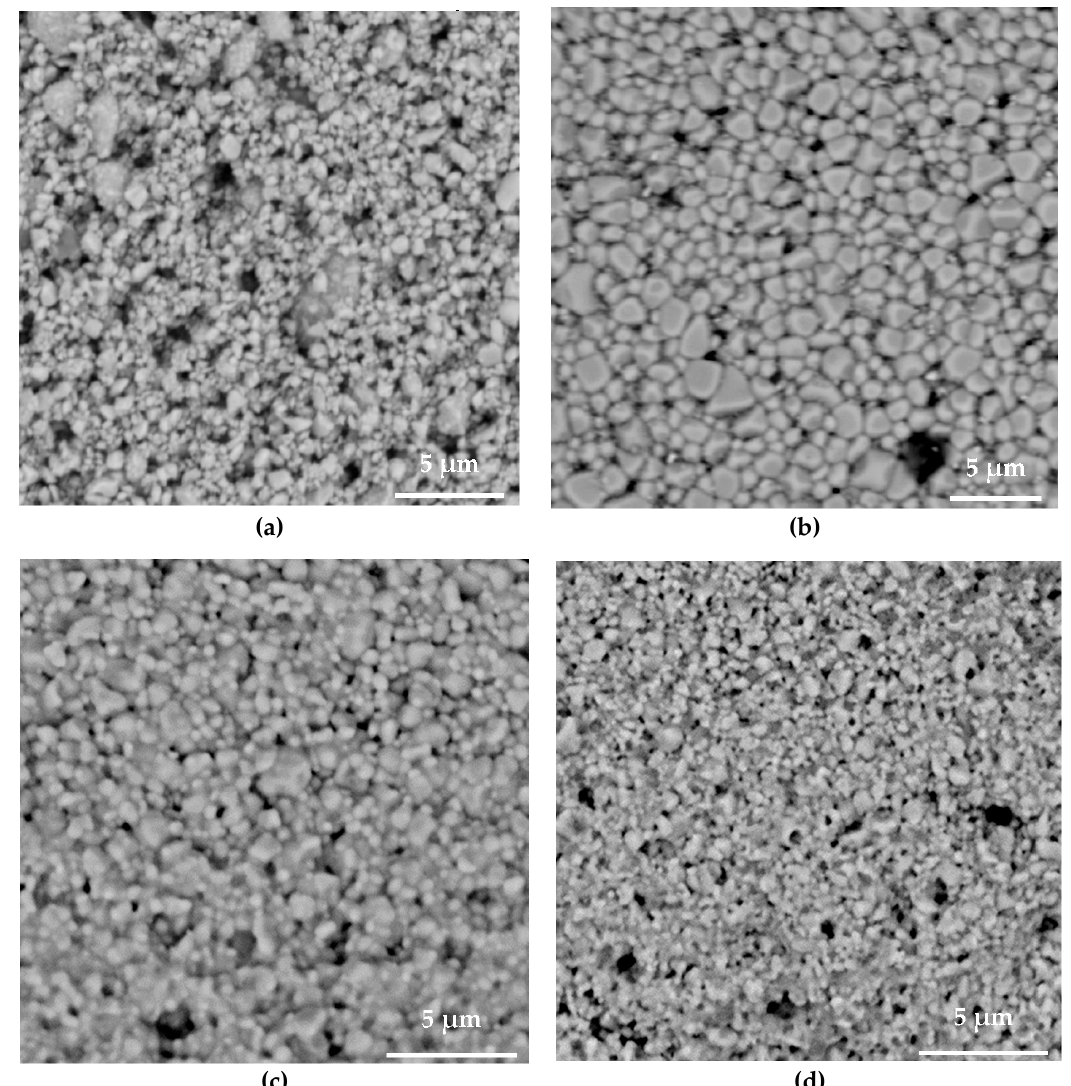
Figure 7. SEM images of ( a ) unsintered PZT, ( b ) furnace-sintered PZT, ( c ) laser-sintered PZT and ( d ) laser-sintered CNT/PZT.